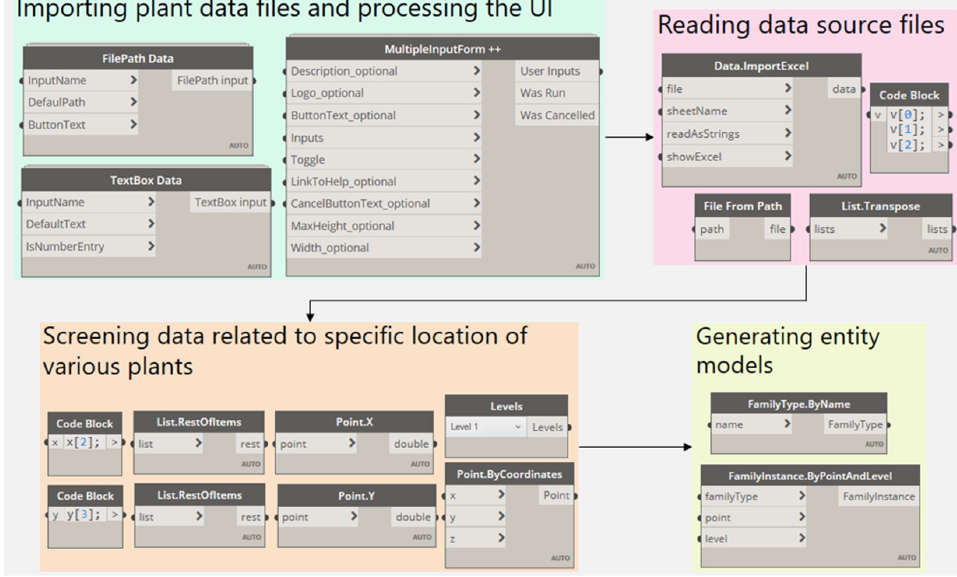
Figure 5. Parametric plant model script (excerpt).